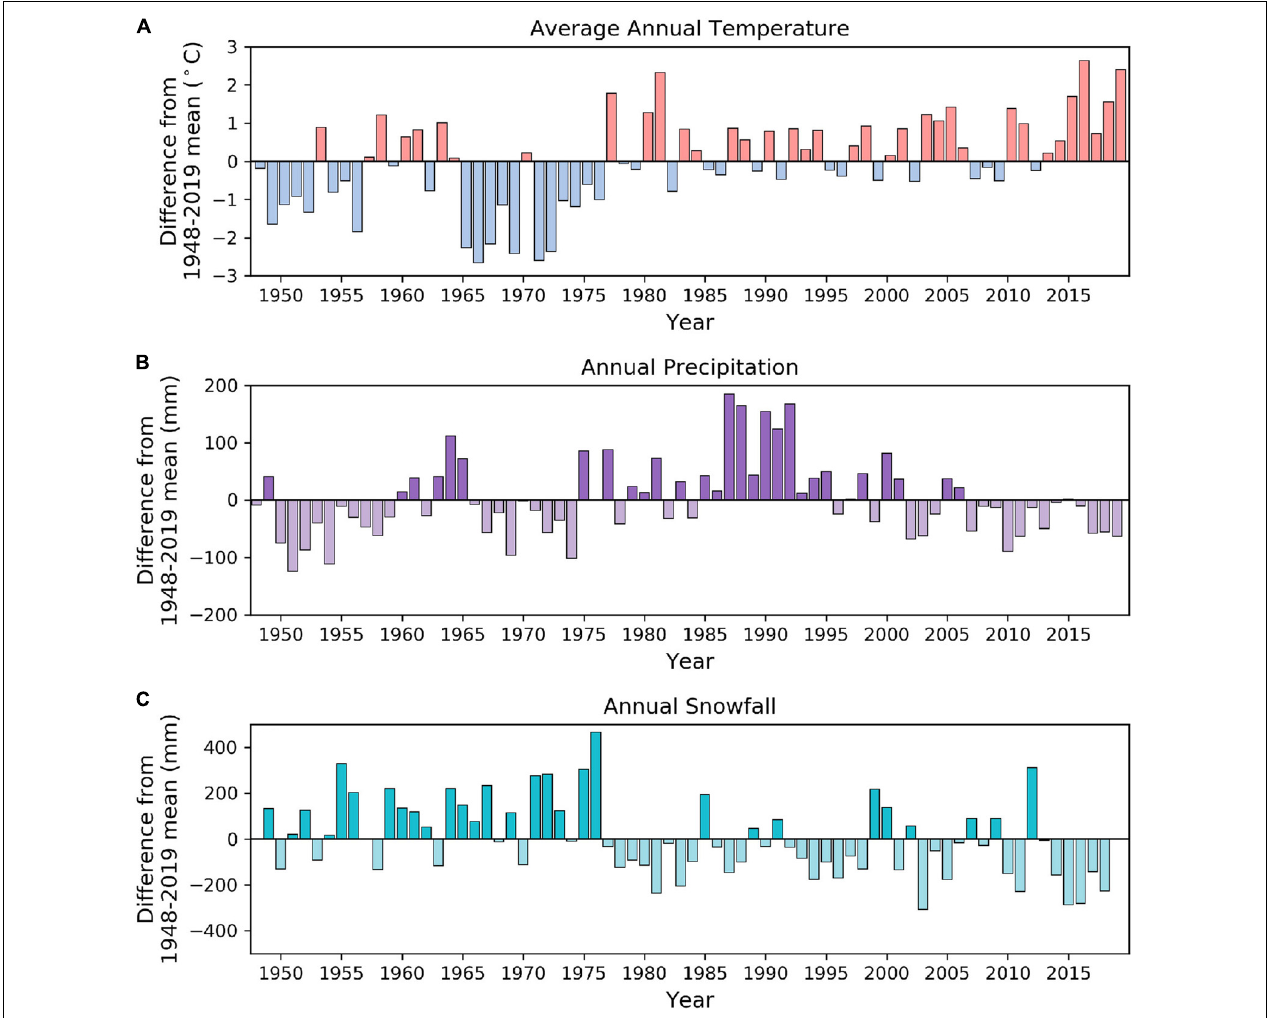
FIGURE 11 | Deviation from 1948 to 2019 mean (A) average annual temperature, (B) annual precipitation and (C) annual snowfall at the Yakutat Airport weather station in southern